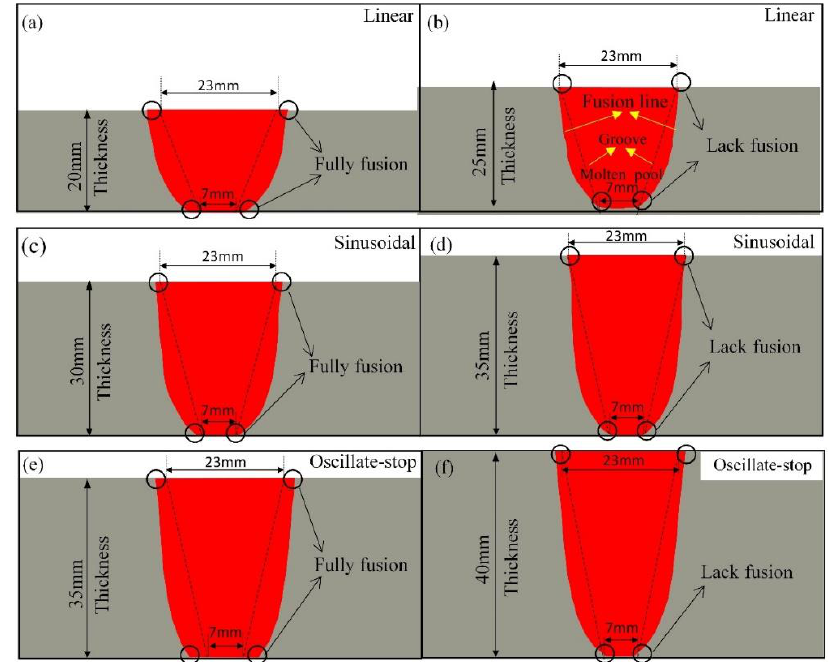
Figure 12. The simulated welding molten pool with three heat sauce paths. Linear heat source path model for 20 mm thickness ( a ), for 25 mm thickness ( b ); Sinusoidal path for 30 mm thickness ( c ), for 35 mm thickness ( d ); Oscillate-stop path for 35 mm thickness ( e ) and for 40 mm thickness ( f ). Simulations were carried out on steel plates with different thicknesses and different heat source models, as listed below. Other modelling parameters are listed in Tables 3 and 4, and the heat input is 157 kJ/cm for all